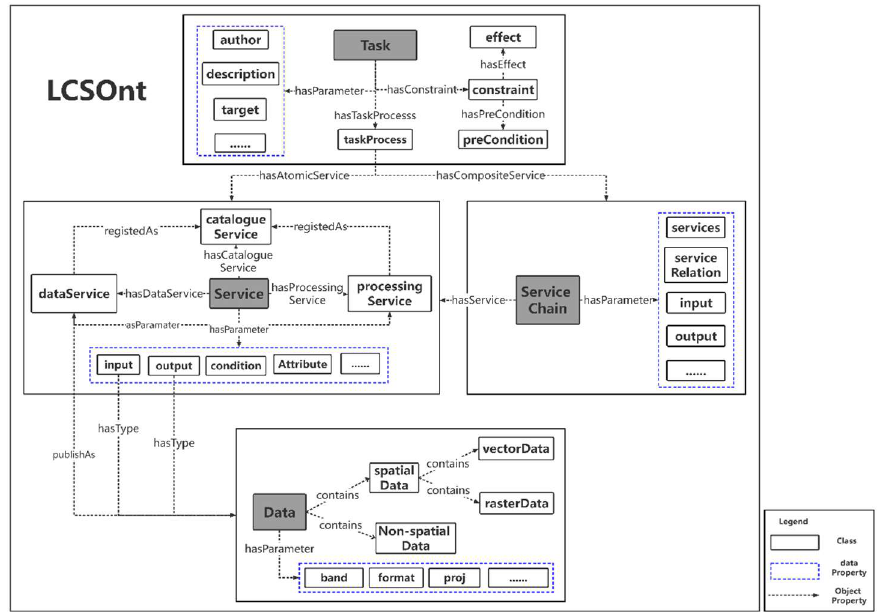
Figure 2. An ontology called LCSOnt describes land cover knowledge and facilitates the connection of land cover